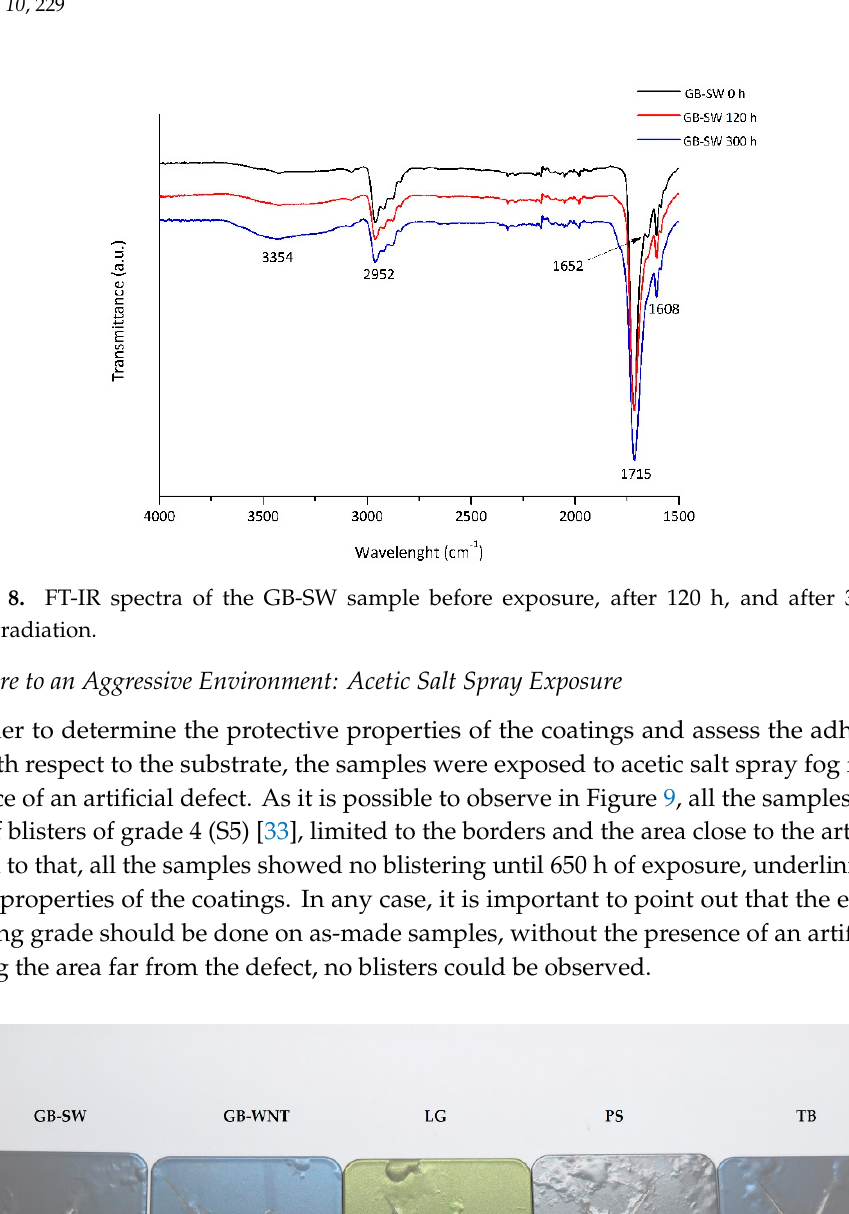
( b ) Figure 7. FT-IR spectra of the GB-SW sample before and after 1000 h of UVB exposure: ( a ) reference spectra; ( b ) close-up of the ( a ) image. Most of the peaks are shifted to lower wave numbers and have a lower transmittance, mainly due to the increase in mobility of the bonds with the absorption of UVB radiation. The two typical peaks of polyester at 1715 and 1652 cm –1 were different after 1000 h of exposure. The first peak underwent a shift towards 1711 cm –1 and a considerable broadening, whereas the latter almost disappeared. After UVB irradiation, a large band at 3354 cm –1 appeared, which could be associated